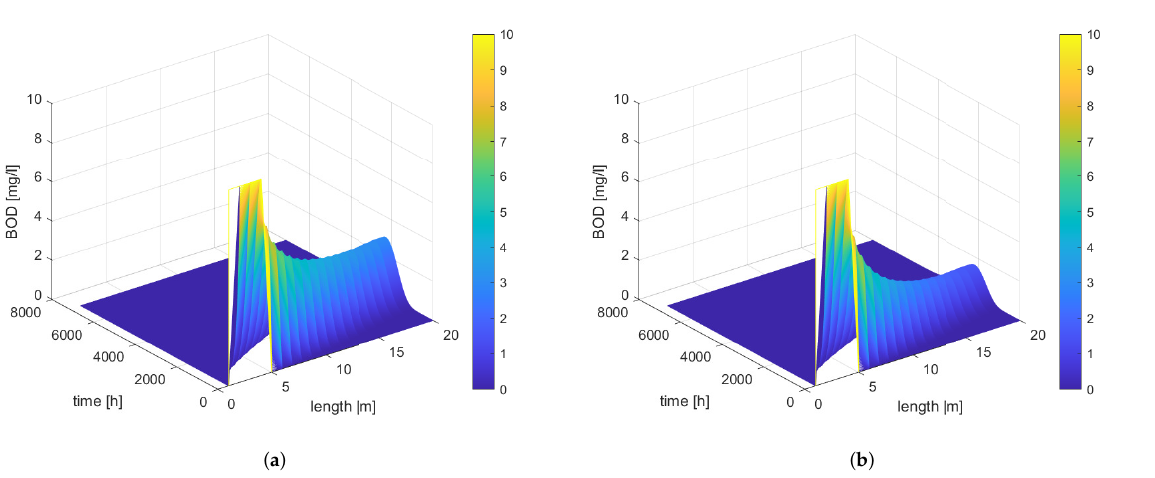
Figure 6. BOD distribution for V = 0.005 ( a ) excluding the self-cleaning process and ( b ) including the self-cleaning process.